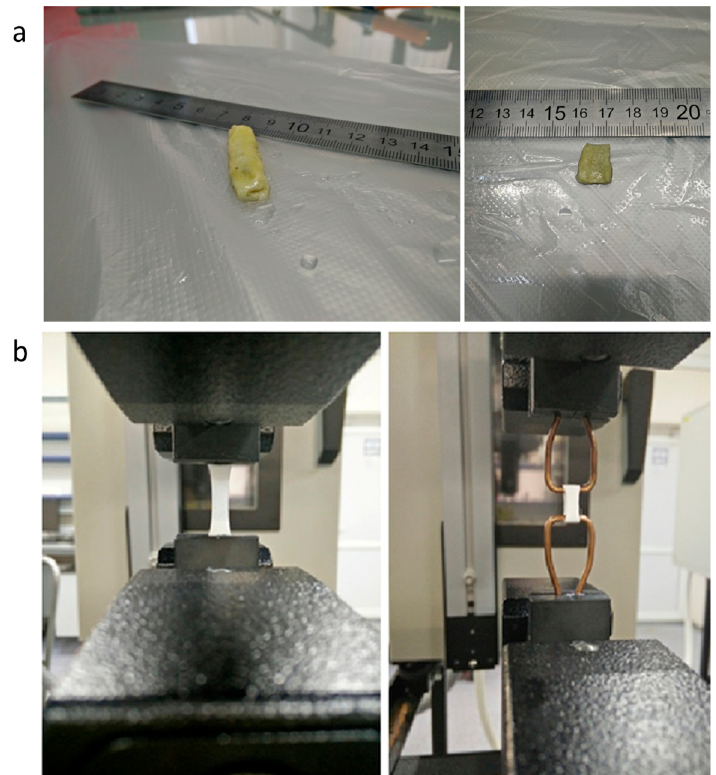
Figure 2. ( a ) Image of a decellularized bile duct specimen before the testing in various test modes; ( b ) Synthetic scaffolds of bile ducts in various modes of testing.